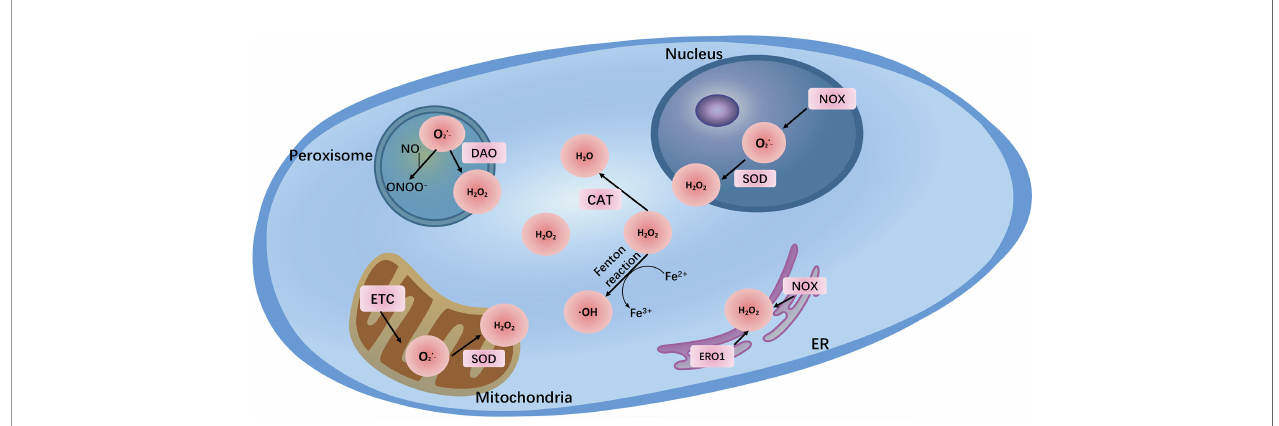
FIGURE 1 | The major reactive oxygen species ( O 2 − , H 2 O 2 , ONOO - ) and their sites of production within cells. The main endogenous sources of ROS are mitochondrial electron transport chain (ETC) and NADPH oxidases (NOXs). In addition, peroxisome and endoplasmic reticulum (ER) also generate ROS. Transition metal ion iron nonenzymatically catalyzes ROS generation via the Fenton reaction.